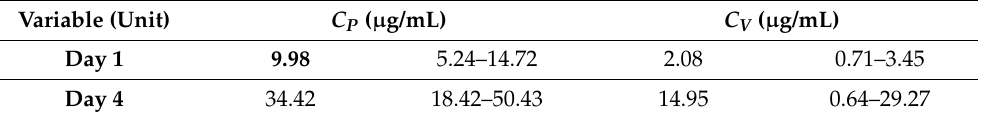
Table 5. Estimated fosfomycin concentrations in prostate ( C P ) and seminal vesicles ( C V ) on Days 1 and 4 after single and multiple dose administration of IMP (N = 22). Variable (Unit) C P ( µ g/mL) C V ( µ g/mL) Day 1